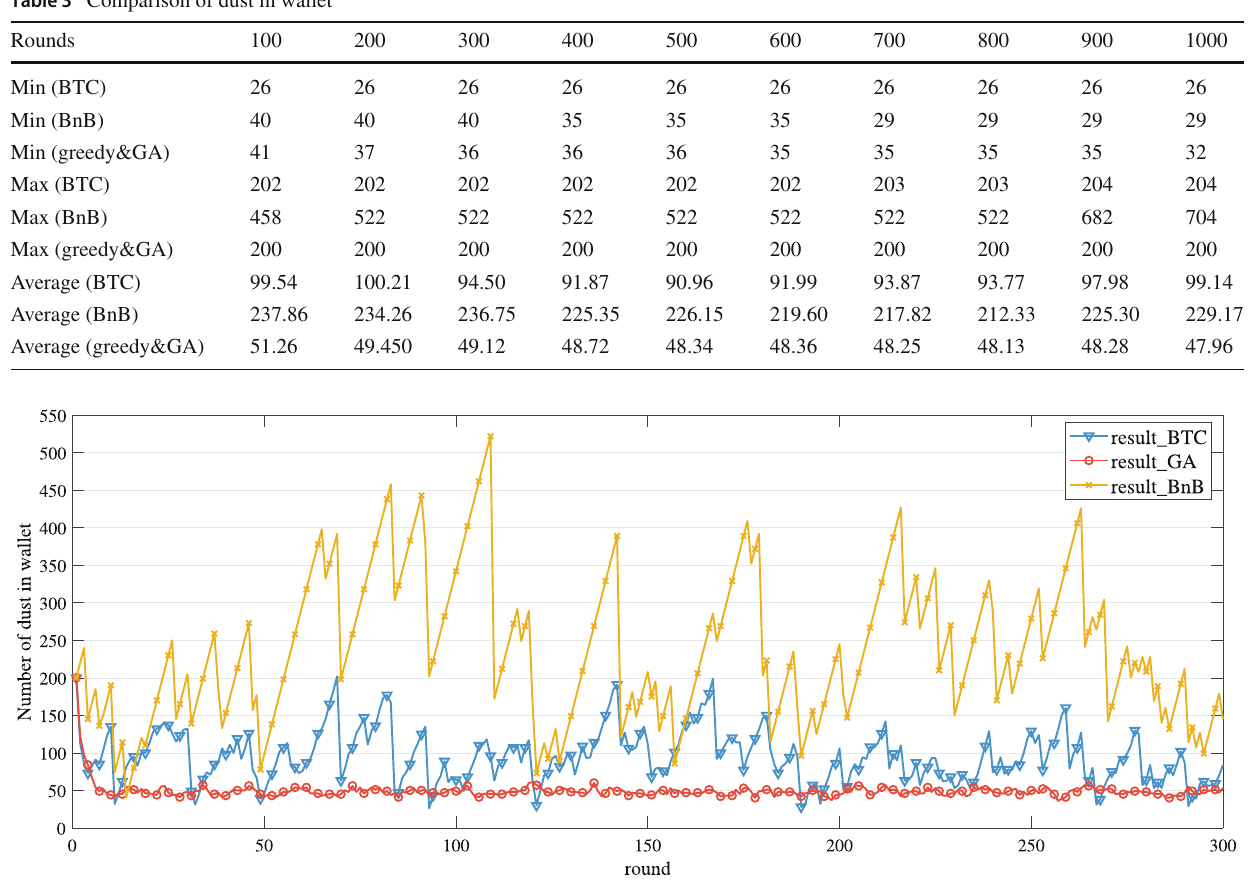
Fig. 12 Comparison of 300 rounds result of dust